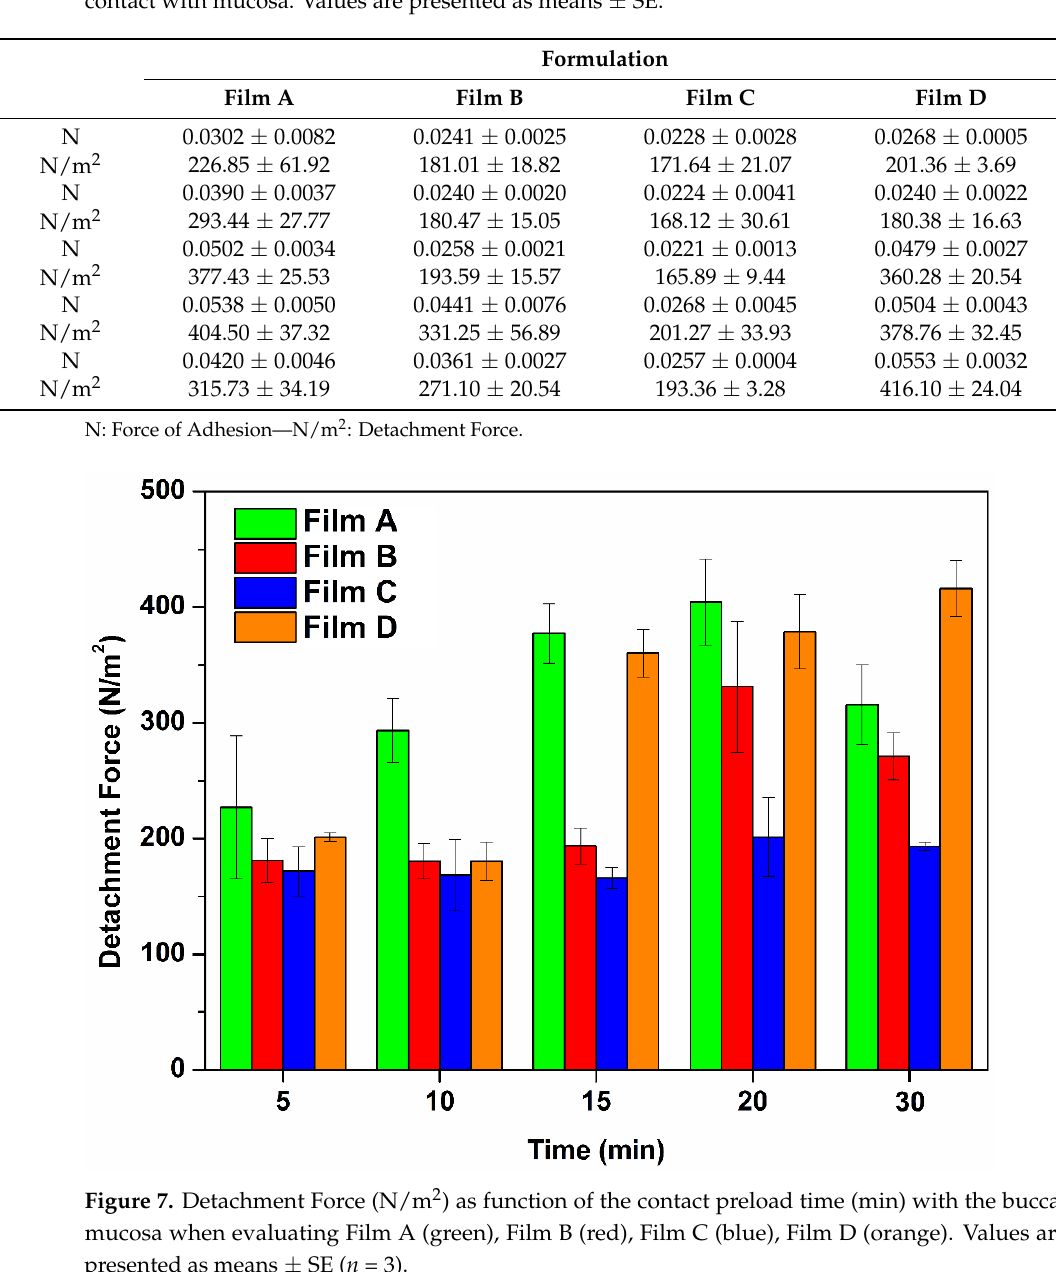
Table 7. Force of Adhesion and Detachment Force of CYT-loaded buccal films as function of time contact with mucosa. Values are presented as means ± SE.